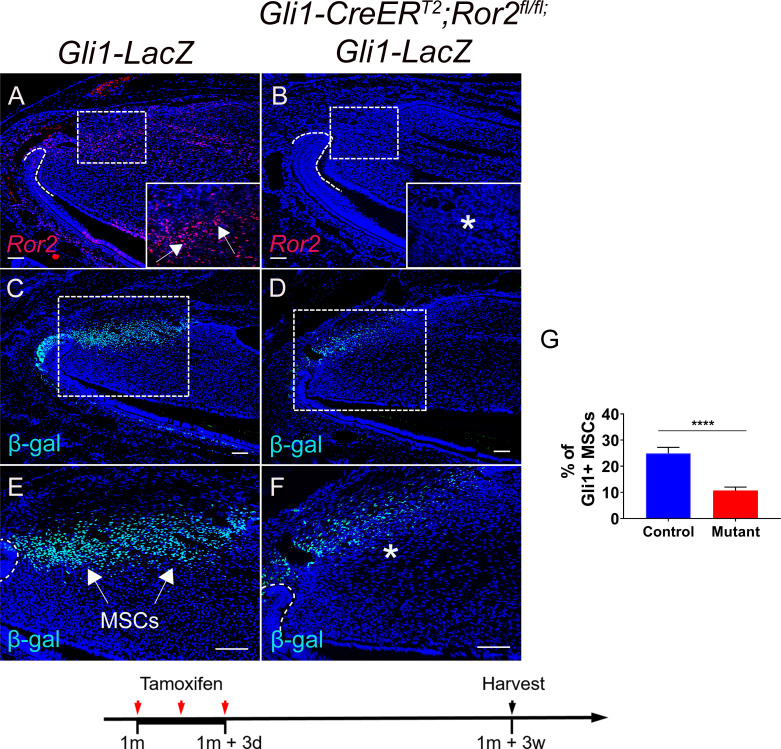
Ror2-mediated non-canonical Wnt signaling regulates mesenchymal stem cell (MSC) maintenance in the incisor.(A and B) RNAscope (red) of Ror2 in incisors from Gli1-LacZ (control) and Gli1-CreERT2;Ror2fl/fl;Gli1-LacZ 1-month-old mice. Insets in A and B show magnified images of the MSC region. (C–F) β-gal staining (green) of incisors from Gli1-LacZ and Gli1-CreERT2;Ror2fl/fl;Gli1-LacZ mice. Boxes in C and D are shown magnified in E and F, respectively. (G) Quantification of the percentage of Gli1+ cells per higher magnification section of Gli1-LacZ (control) and Gli1-CreERT2;Ror2fl/fl;Gli1-LacZ (mutant) mouse incisor mesenchyme in E and F. Gli1+ cells in the proximal region between the two cervical loops were counted in the mouse incisor. Quantitative data are presented as mean ± SD. ****, p<0.0001. Arrows indicate positive signal and asterisks indicate diminished signal. Schematic at the bottom indicates induction protocol. Scale bars, 100 μm.Figure 6—source data 1.Source data for Figure 6G.